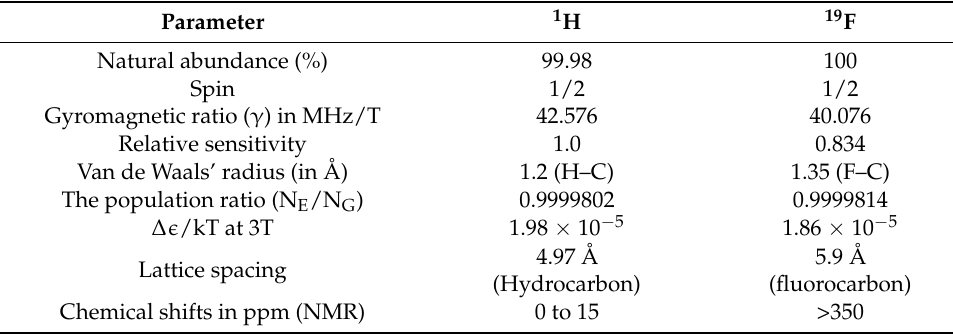
Table 2. Comparative properties between hydrogen and